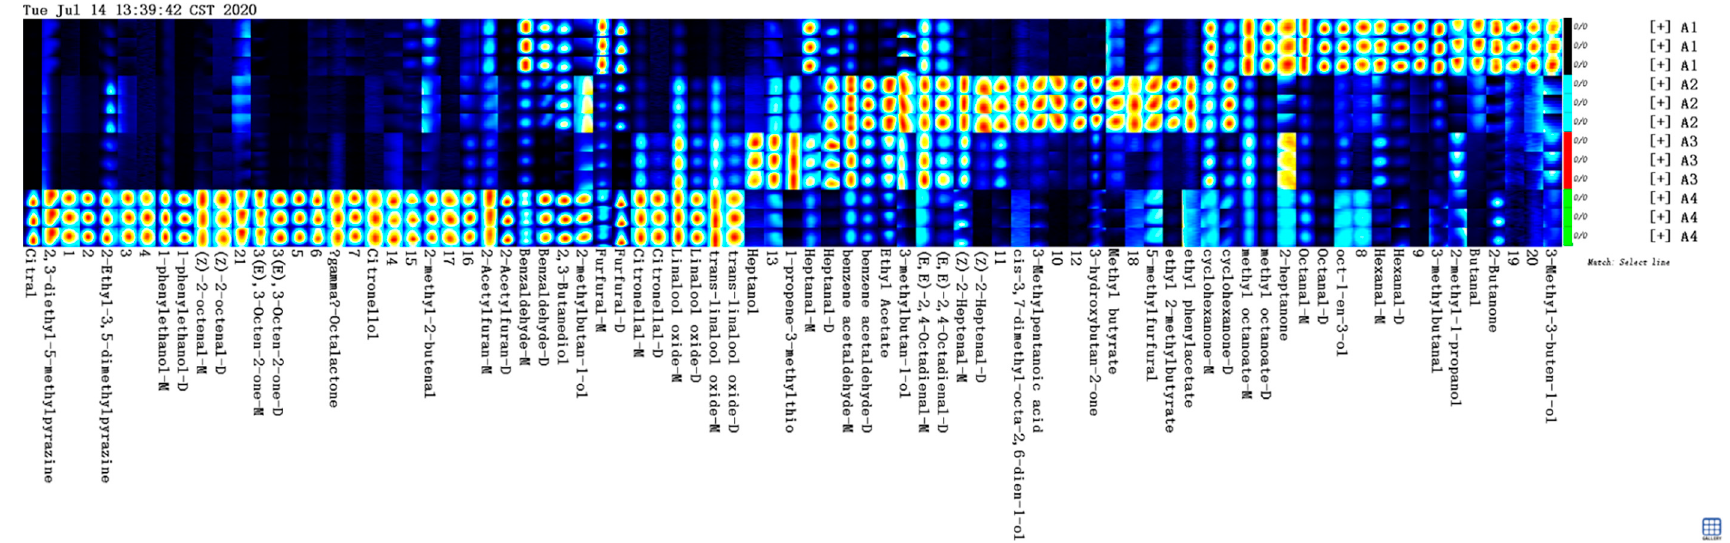
Figure 2. Gallery plot of the selected signal peak areas obtained with 4 kinds of honey samples. A1: Fennel honey; A2: Agastache honey; A3: Pomegranate honey; A4: Manuka 12+ honey.